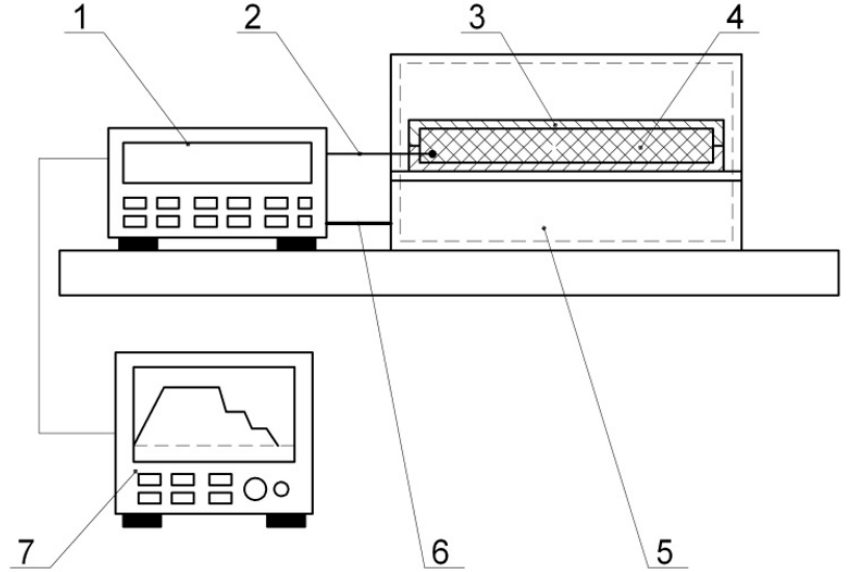
Figure 5. Test bench layout: 1—thermostat (TERMOTET 04/2); 2—thermocouple; 3—shaping surface; 4—moulded PCM package; 5—SNOL 60/300 NL Curing Oven; 6—supply; 7—data recorder (computer with the special soft).